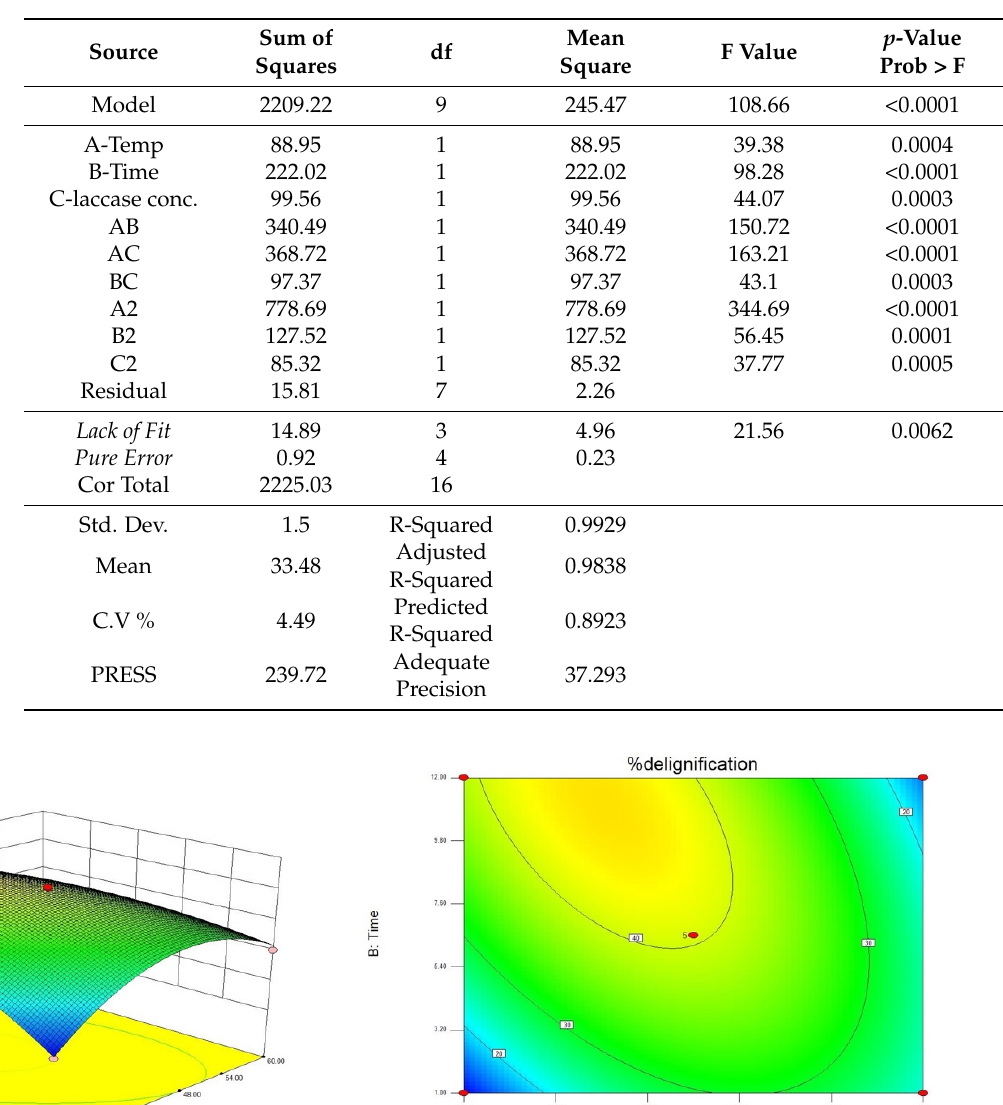
Table 4. Experimental matrix and results of delignification of rice straw.